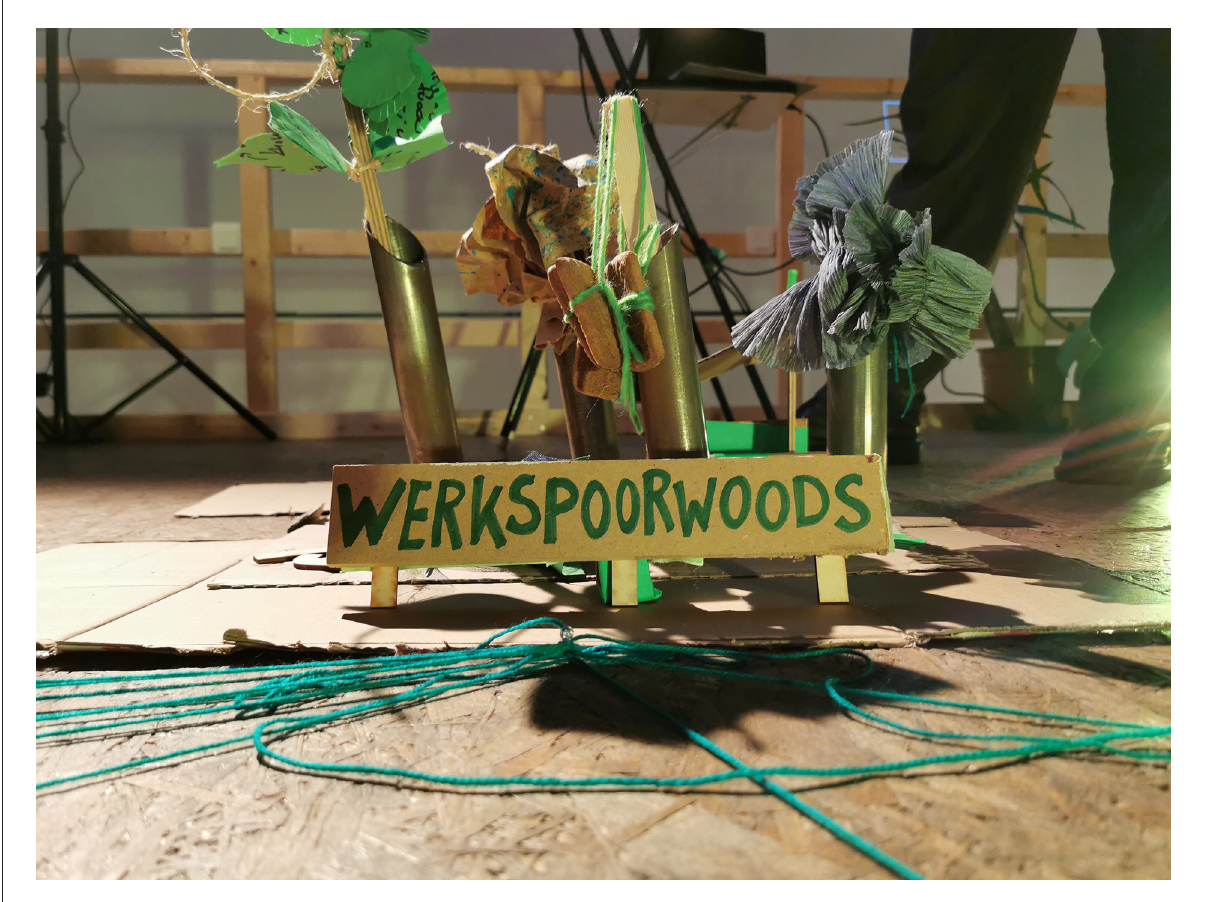
FIGURE9 Werkspoorwoods as a speculative object for forest